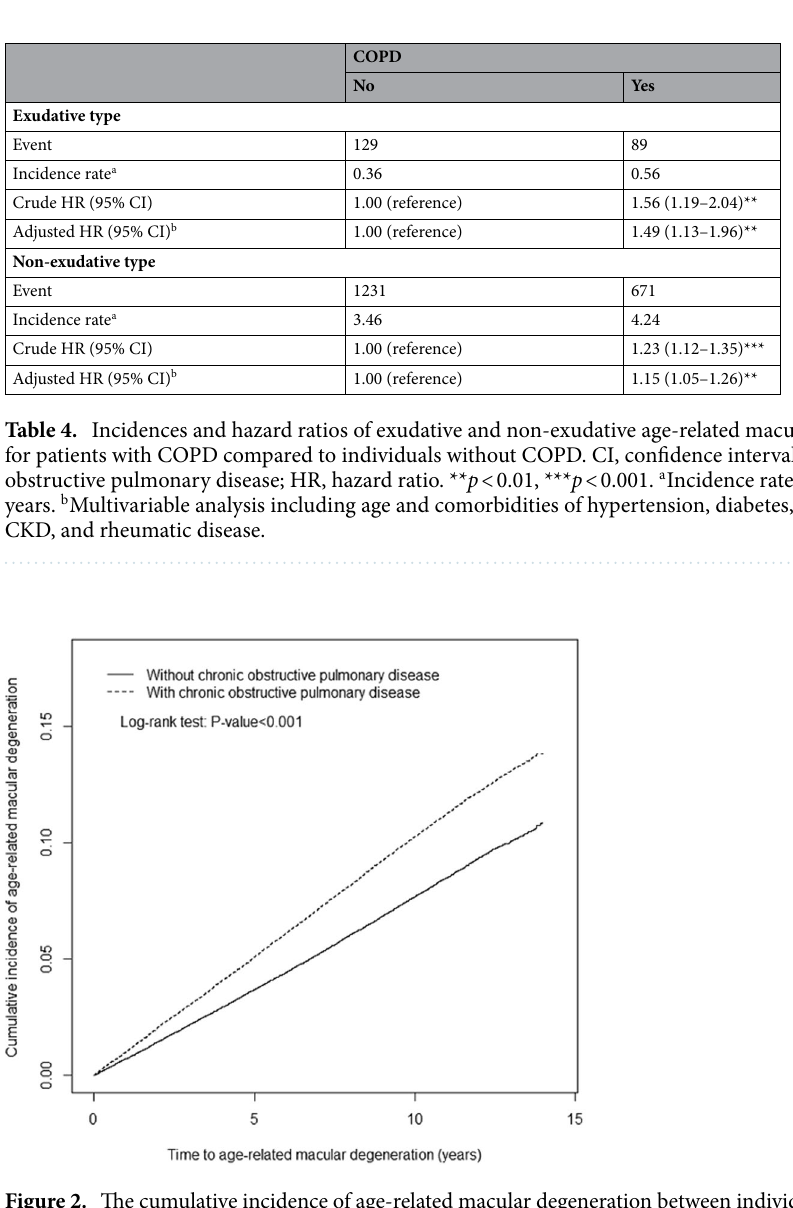
Figure 2. The cumulative incidence of age-related macular degeneration between individuals with and without chronic obstructive pulmonary